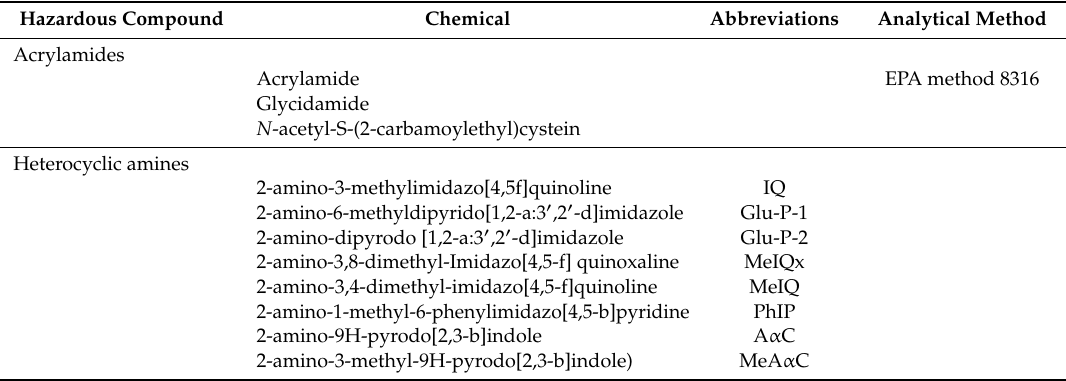
Table 2. Hazardous compounds and their chemicals collected in this